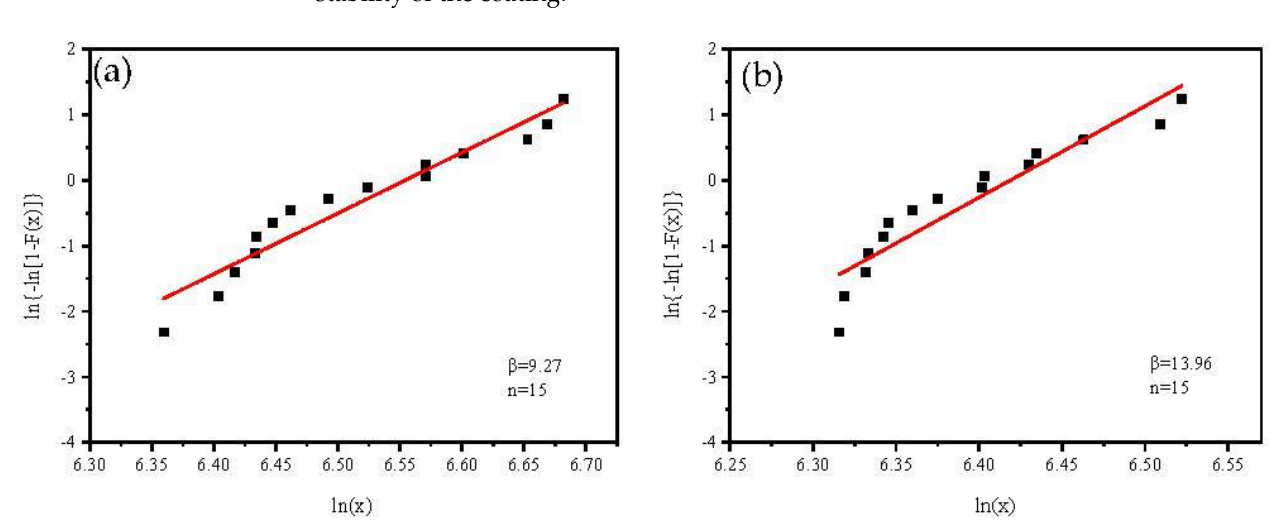
Figure 7. Weibull plots of mirohardness for Stellite 20 coatings deposited by HVAF ( a ) and HVOF ( b ).